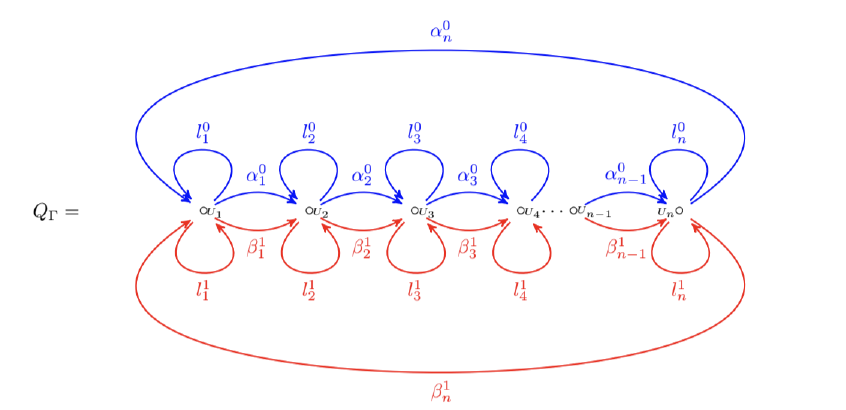
Figure 1. Brauer quiver induced by a { 0,1 } -Brauer configuration. Symbols l i j ∈ { 1,2, . . . , n } mean that the corresponding vertex U j has associated l i different